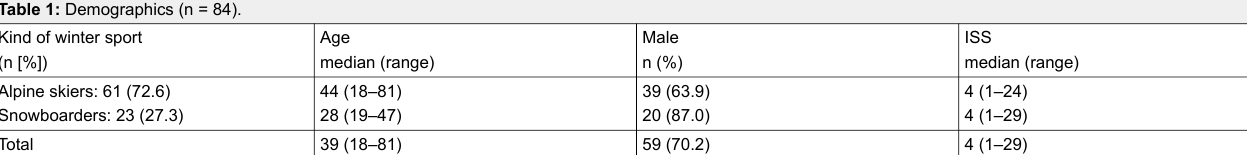
ISS median (range)